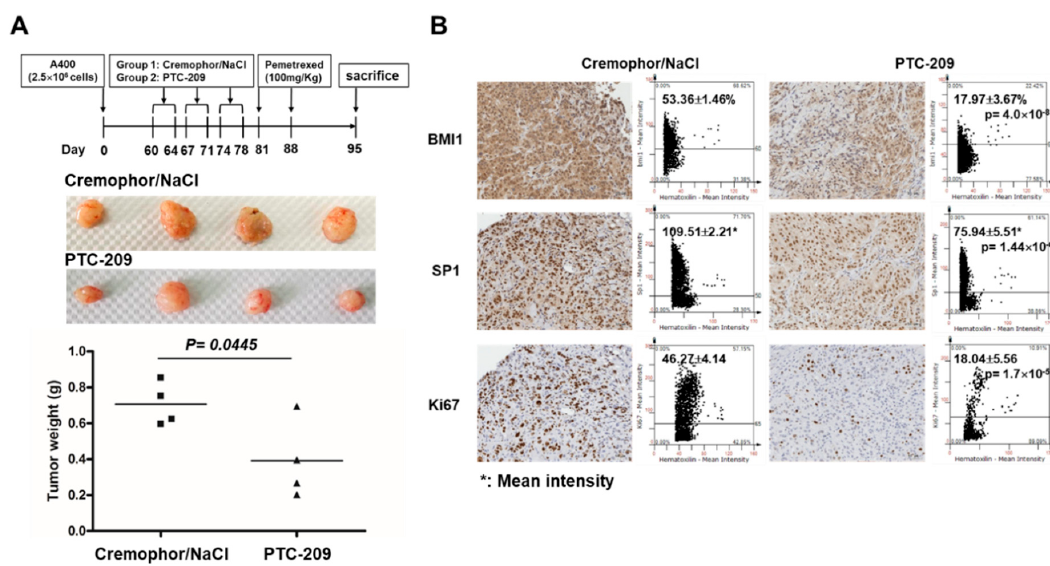
Figure 7. PTC-209 sensitizes NSCLC tumors toward pemetrexed treatment in vivo. Pemetrexed-resistant A400 cells were subcutaneously inoculated into the back skins of NOD/SCID mice as 2.5 × 10 6 cells/mouse (n = 4). After tumor volume reached to 50 mm 3 , the mice were divided into two groups: group 1: vehicle (Cremophor/NaCl) or group 2: PTC-209 treatment with intraperitoneal injection at a dose of 20 mg/kg for 5 days/week, the treatments were done for a total of 3 weeks. After 7 days from last shot of vehicle or PTC-209, all the mice were treated with pemetrexed at a dose of 100 mg/kg for two times with an interval of 7 days. The mice were then sacrificed at Day 7 after the last treatment of pemetrexed. ( A ) Tumors were harvested and the weight was compared between vehicle pre-treated control group and PTC-209 pre-treated group. ( B ) Paraffin embedded tumor tissues were sliced into 4 µm sections and immunohistochemistry analysis was performed to evaluate the protein expression of BMI1, SP1, and Ki67. The images were quantified by TissueFAX software to measure the positive percentages or mean staining intensity.